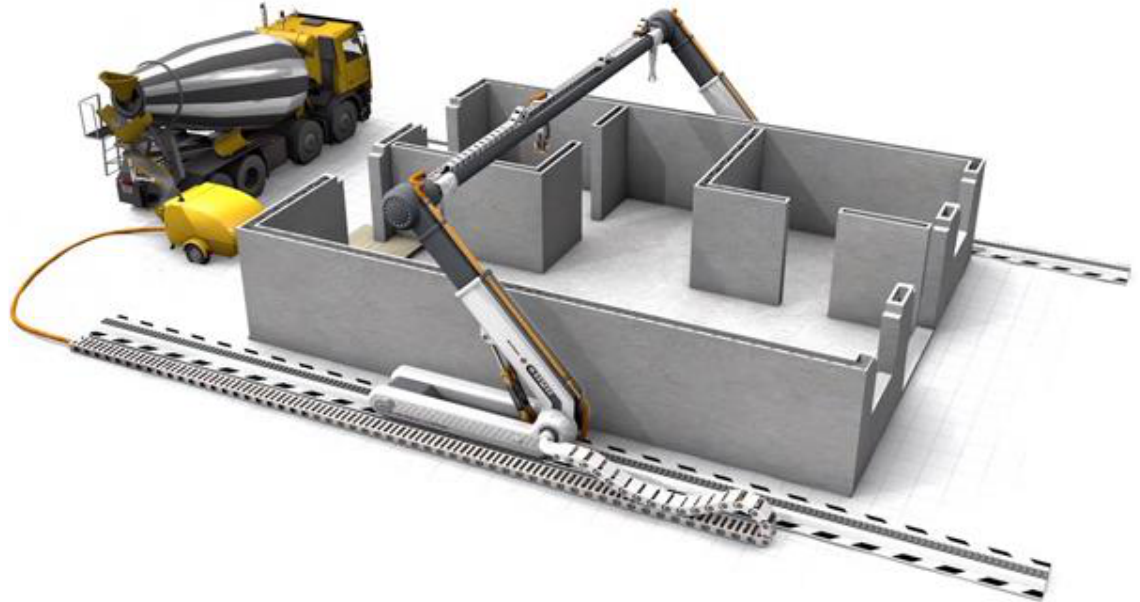
Figure 1. Construction of buildings using 3D-concrete printing.